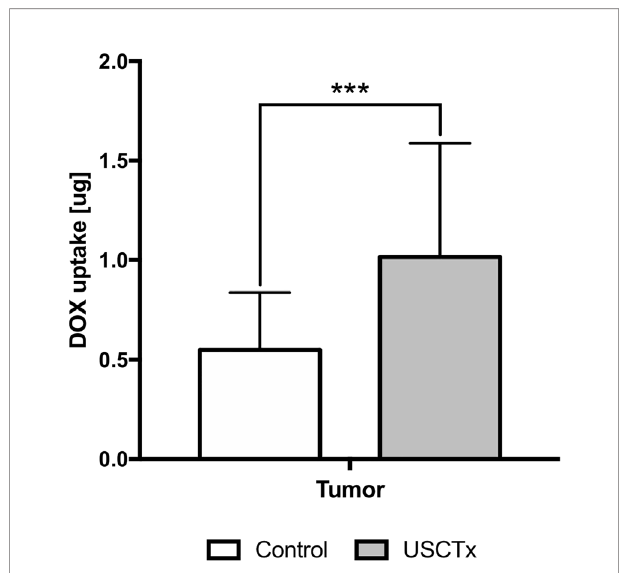
FIGURE 7 | DOX uptake in USCTx versus control mice. Doxorubicin amount is presented in micrograms (per equivalent tissue homogenate mass). ***p < 0.001.